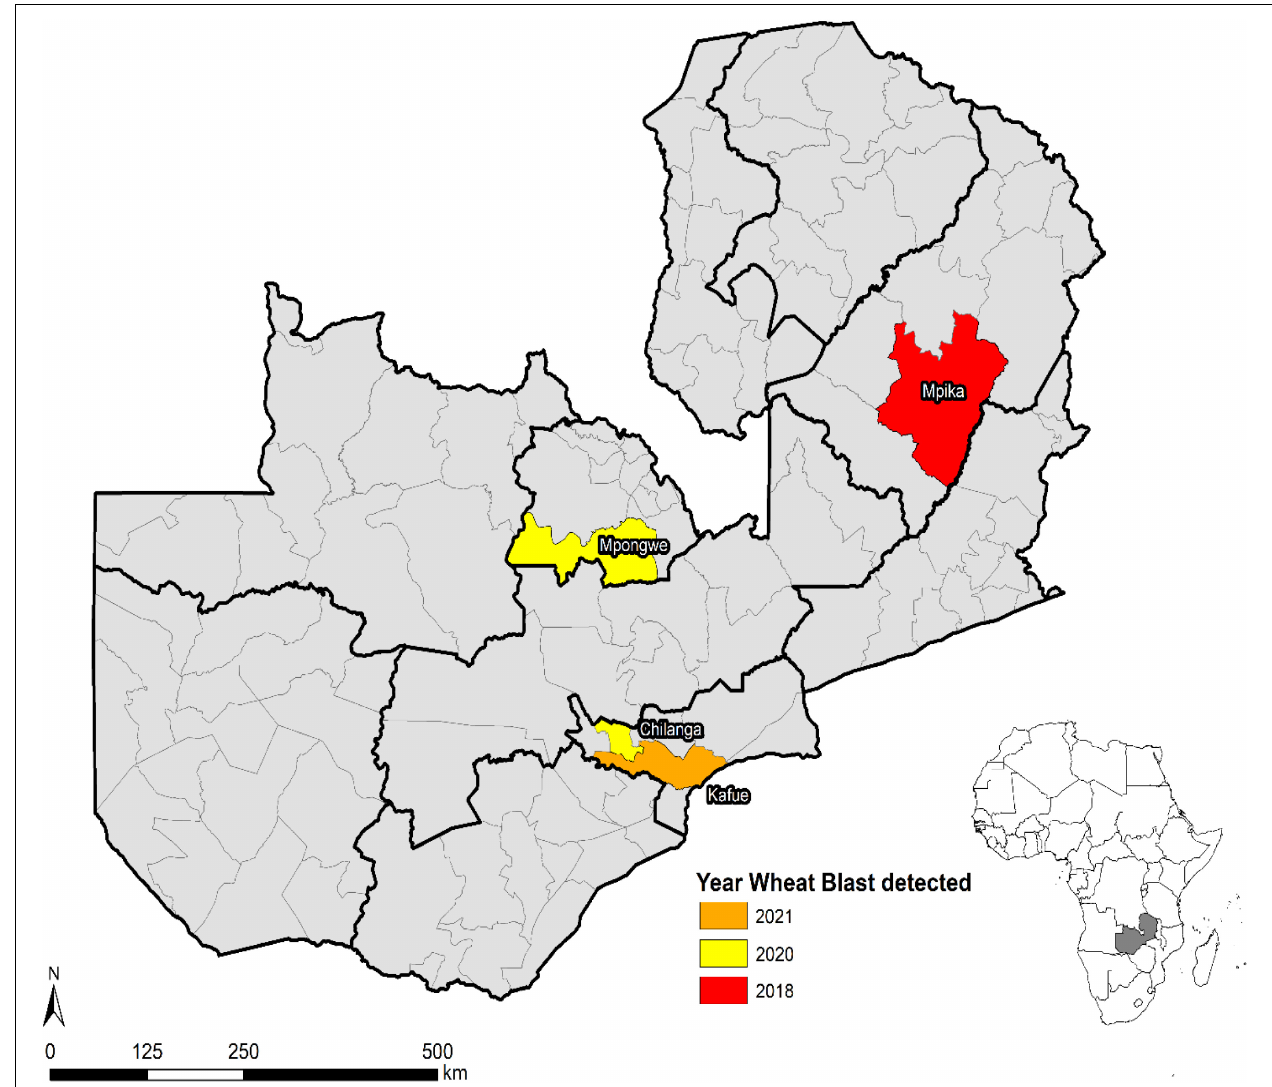
FIGURE 6 | Spread of wheat blast in Zambia from 2018 to